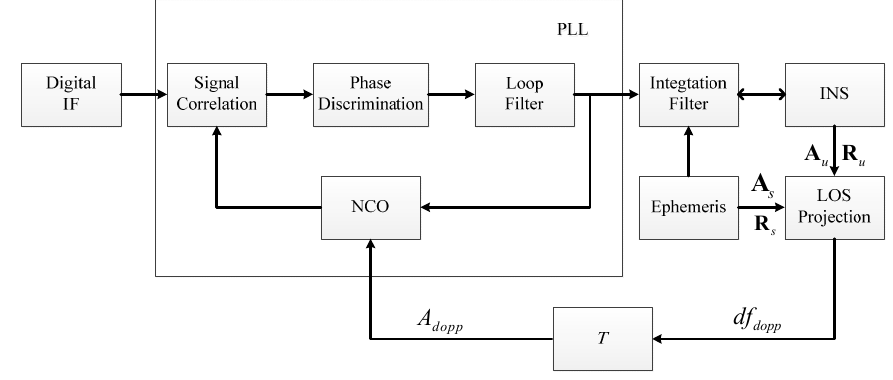
Figure 1. The delta Doppler aided PLL architecture.